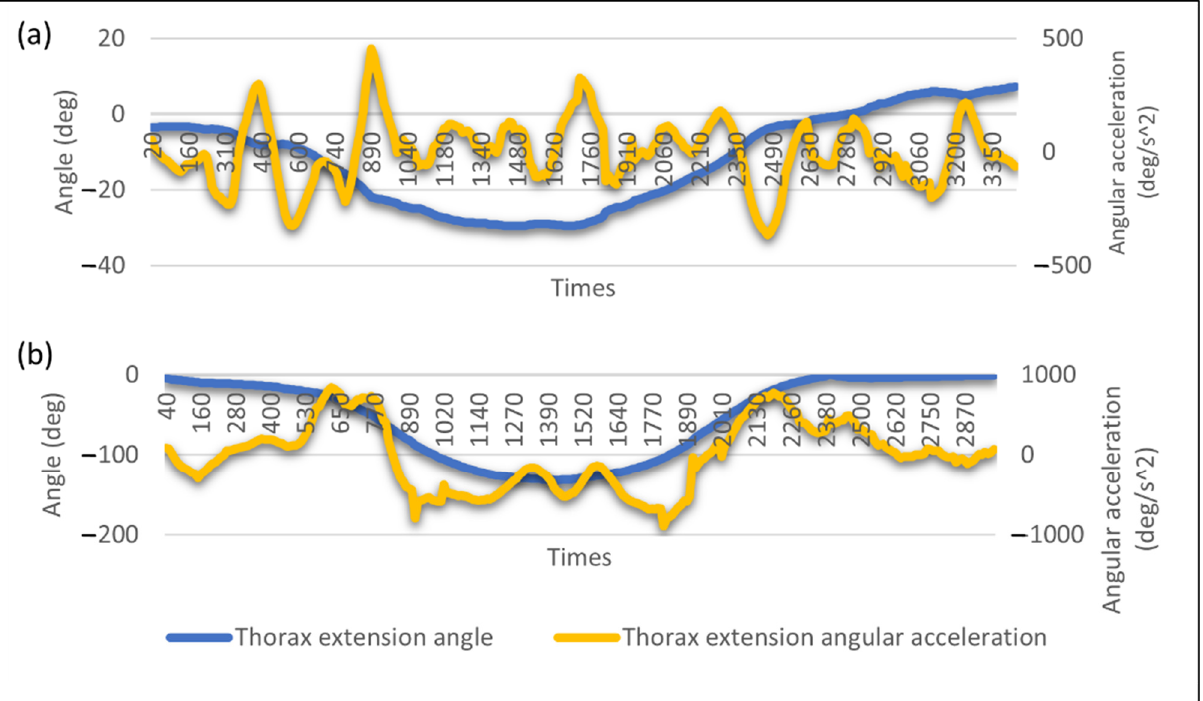
Figure 8. Example of angle deviation and angular acceleration profile for ( a ) squatting lifting posture and ( b ) stooping lifting posture.